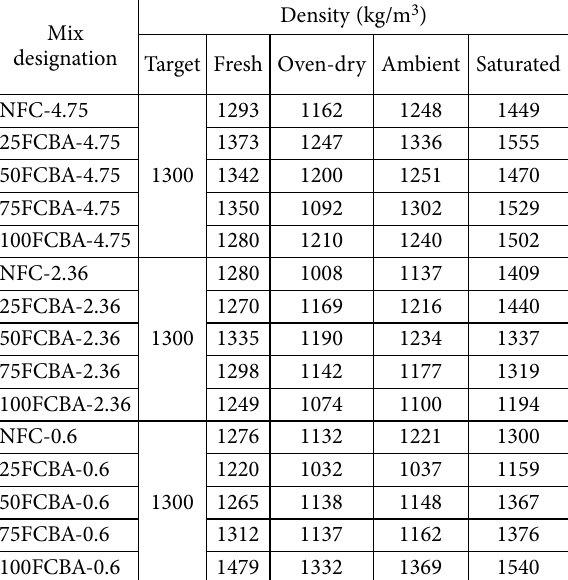
Table 5. Density of specimens (kg/m 3